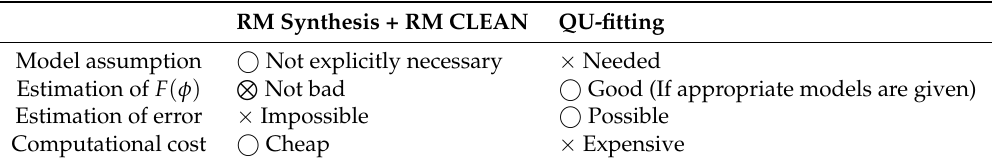
Table 1. Comparison of pros ( (cid:13) ) and cons ( × ) of F ( φ ) estimation